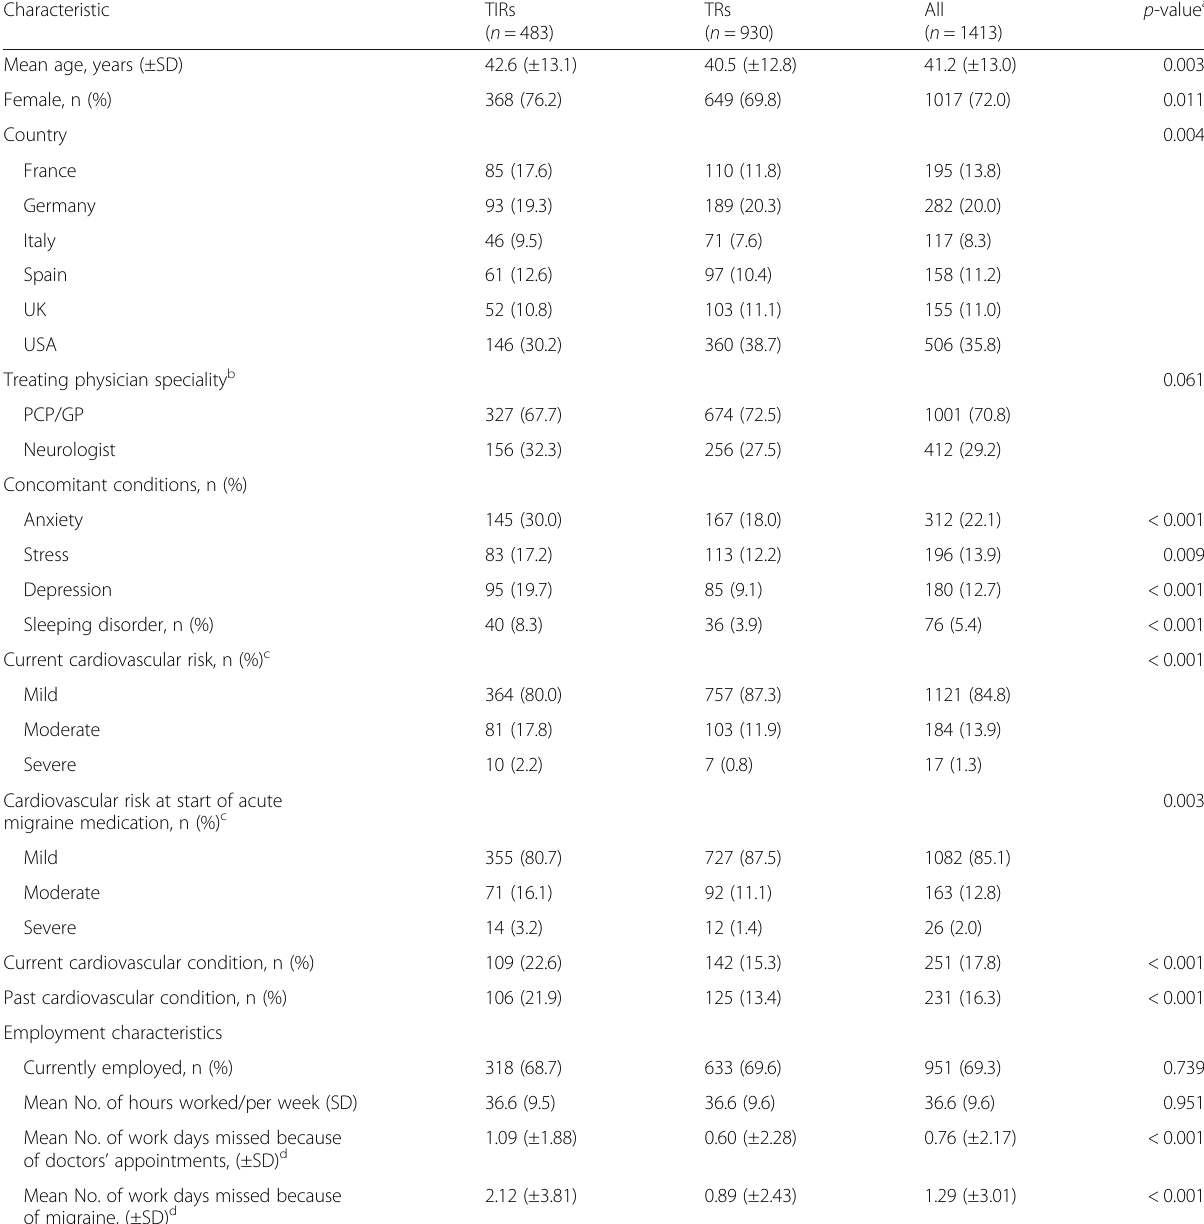
Table 1 Patient demographic and clinical characteristics (physician reported)